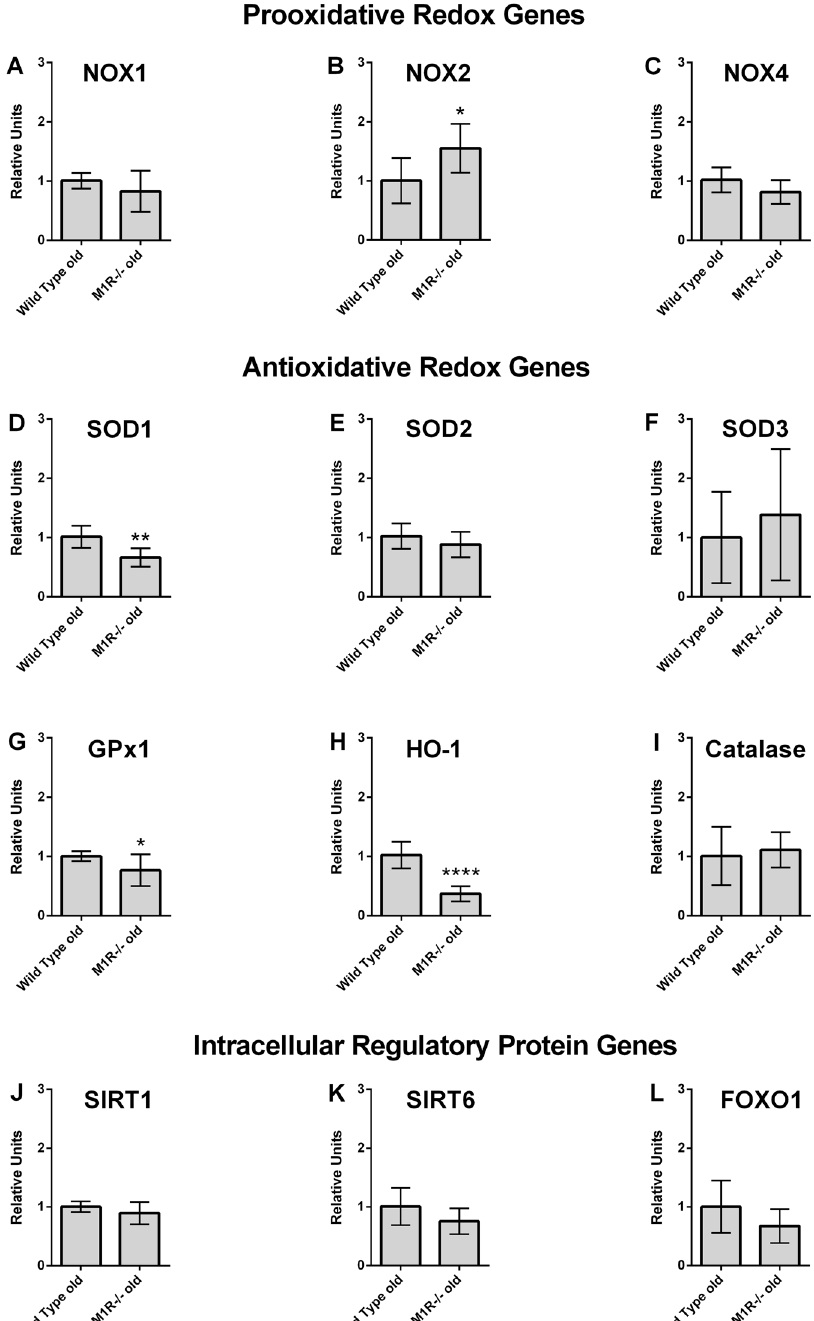
Figure 5. Messenger RNA expression of prooxidative genes (NOX1, NOX2, NOX4), antioxidative genes (SOD1, SOD2, SOD3, GPx1, HO-1, Catalase) and of genes coding for intracellular regulatory proteins involved in aging (SIRT1, SIRT6, FOXO1) in aged wild-type and M1R − / − mice. Expression of NOX2 was significantly increased in aged M1R − / − mice. In contrast, the antioxidative redox genes, SOD1, GPx1 and HO-1, showed reduced expression levels in aged M1R − / − mice. Data are presented as mean ± SD (n = 8 per genotype; * p < 0.05; ** p < 0.01; **** p <